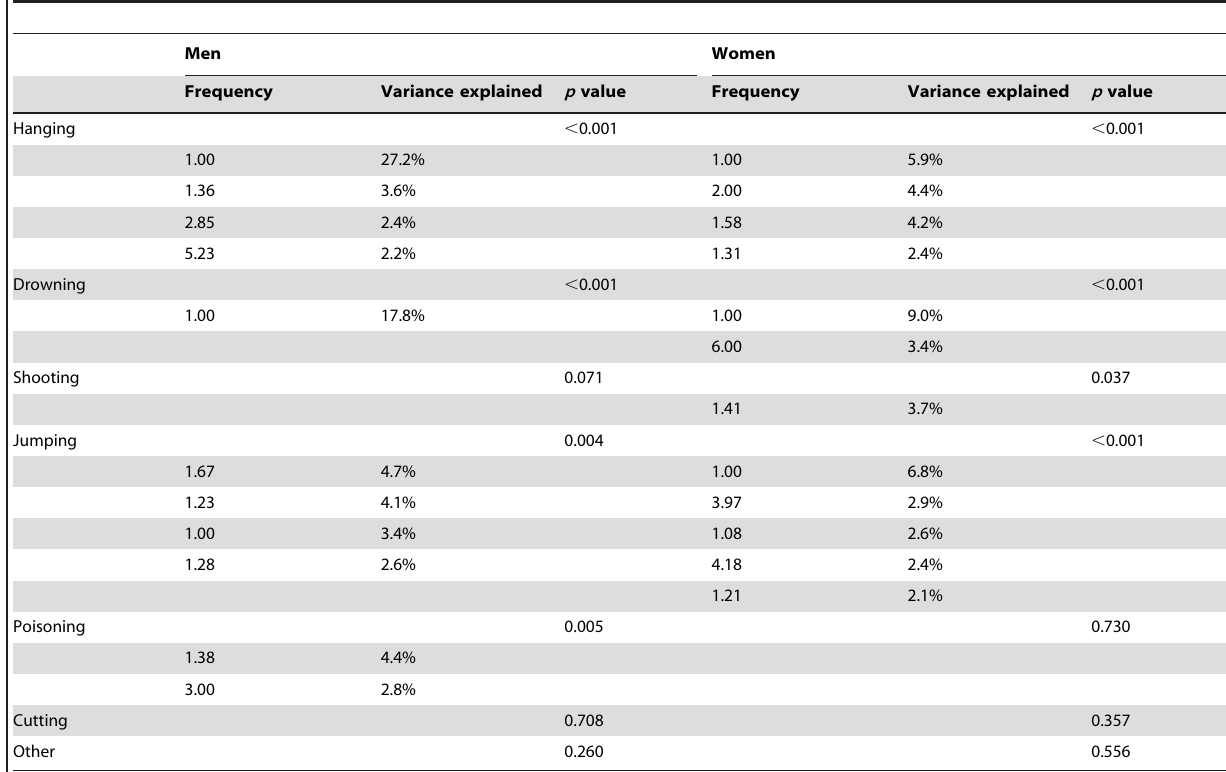
Table 2. Suicide seasonality for specific suicide methods for men and for